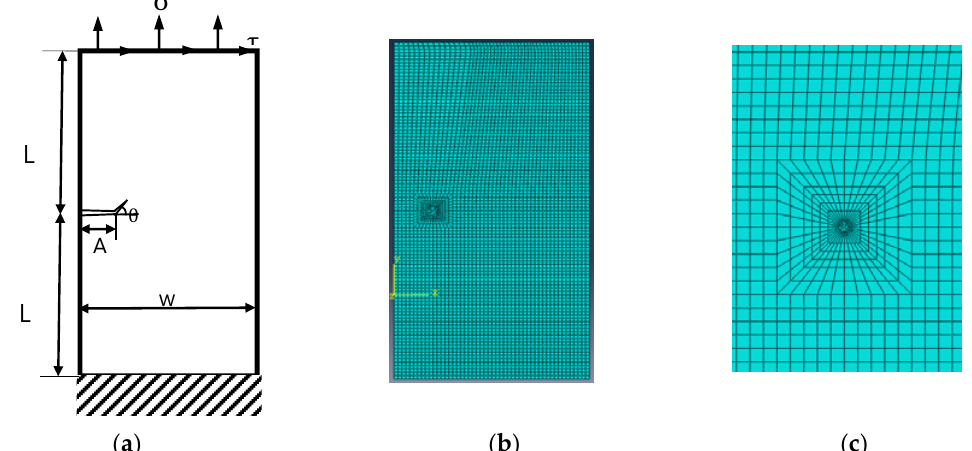
Figure 1. Crack model in ABAQUS. ( a ) A rectangular plate with crack; ( b ) The finite element model; ( c ) Drawing of partial enlargement for crack.